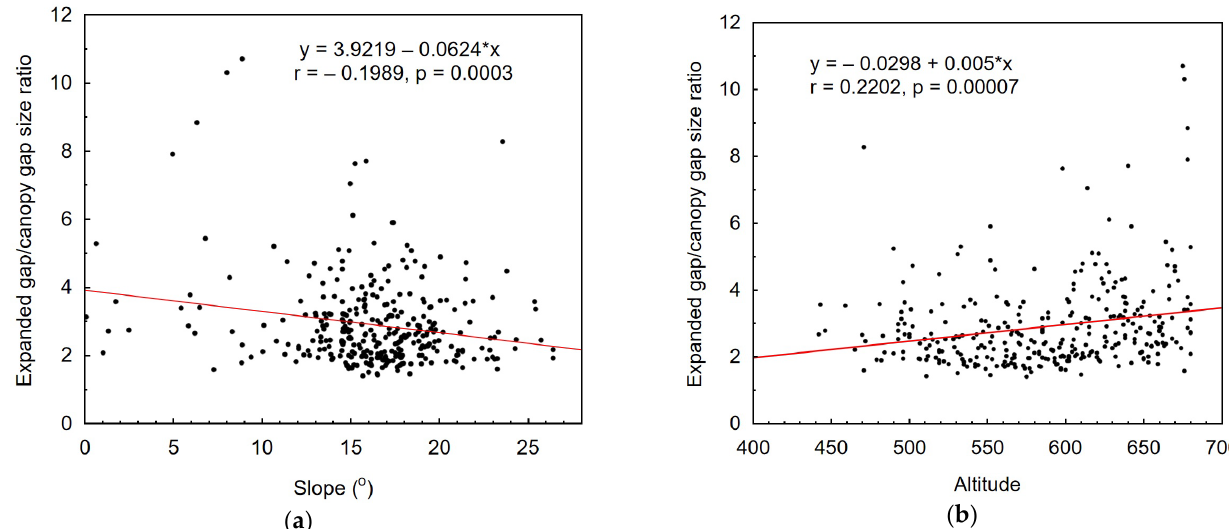
Figure 5. Variation in the expanded gap/canopy gap size ratio with slope ( a ) and altitude ( b ).